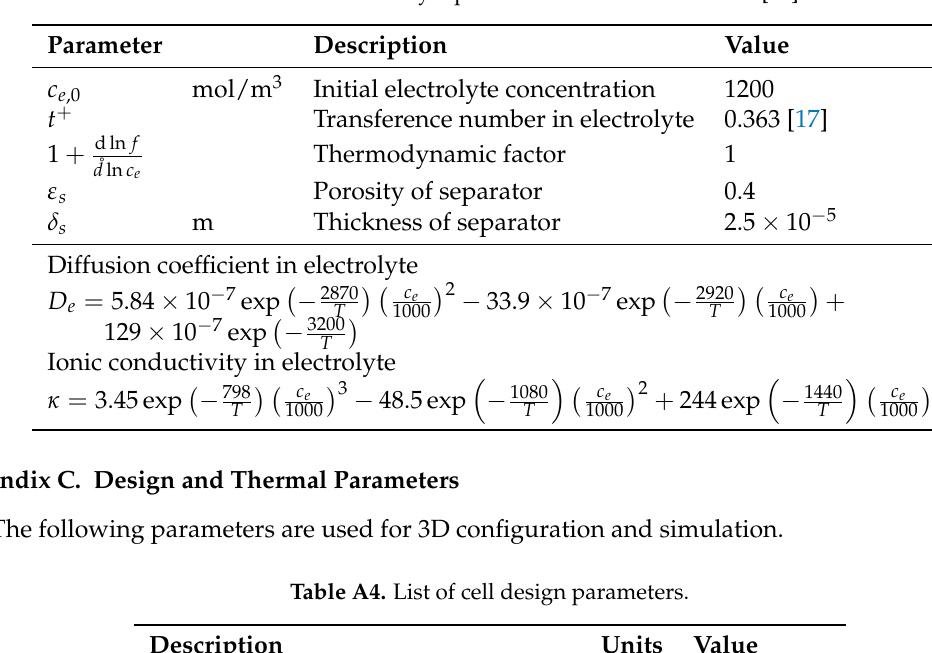
Table A3. List of electrolyte parameters used in simulation [12].